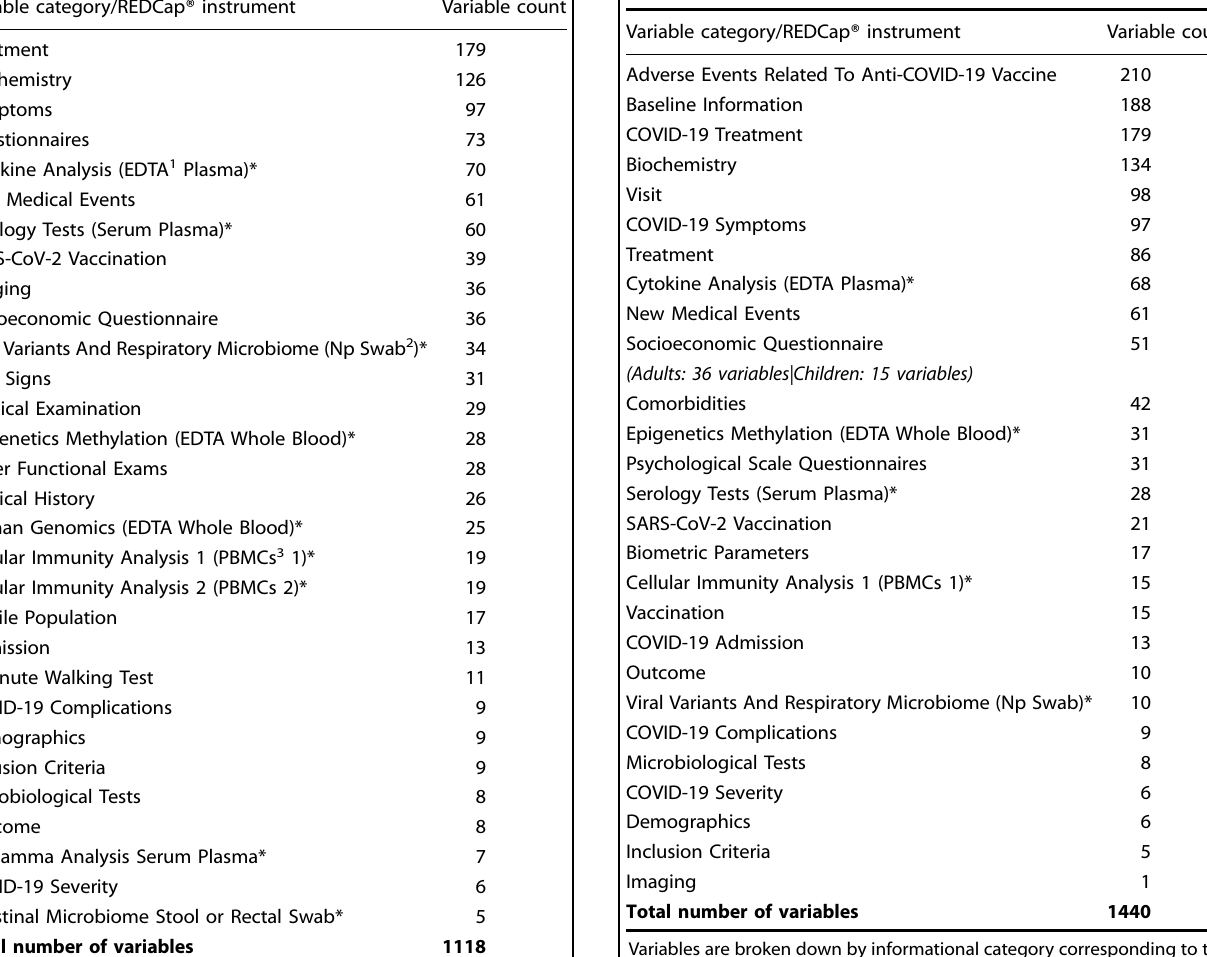
Table 1. Variables de fi ned and used in the LTS study. Table 2. Overview of the variables de fi ned and used in the Fragile Population